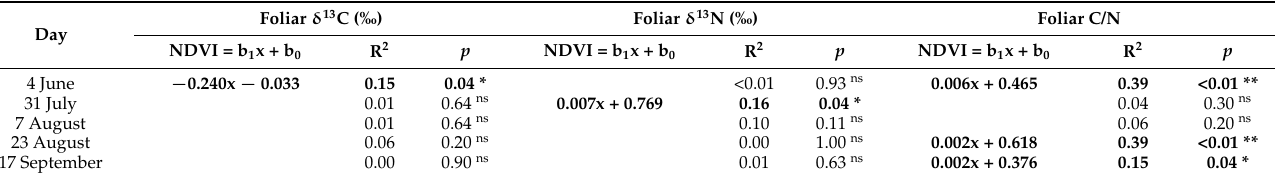
Bold font indicates a significant relationship. Significance levels ( p values) were flagged as * p < 0.05, ** p < 0.01, ns—not